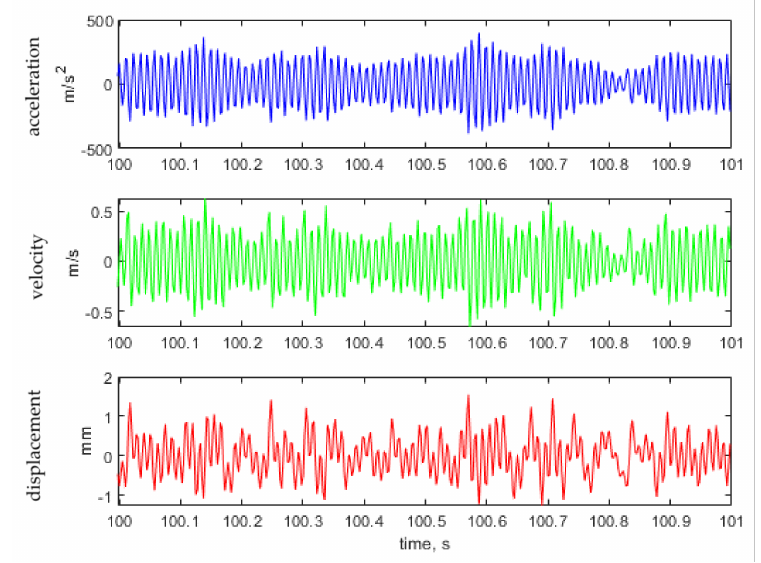
Figure 12. Representative time histories of acceleration measured on additional mass (see Figure 4) and the calculated velocity and displacement for the excitation signal with kurtosis parameter Ku = 4.